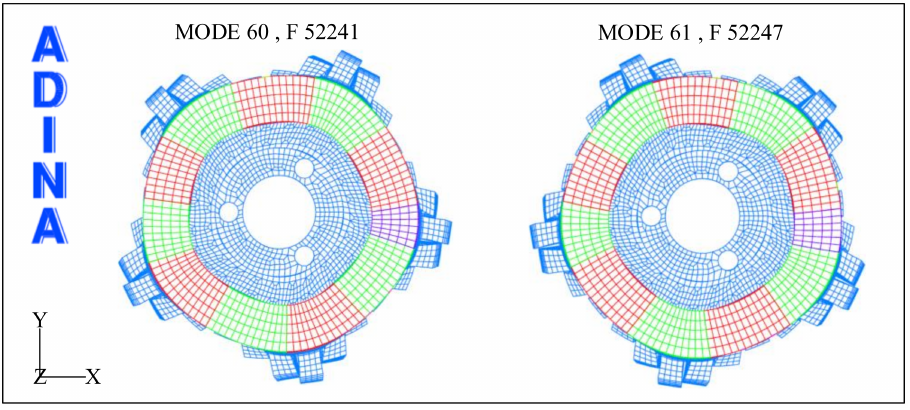
Figure 7. Operating modes of the stator in the simulation.